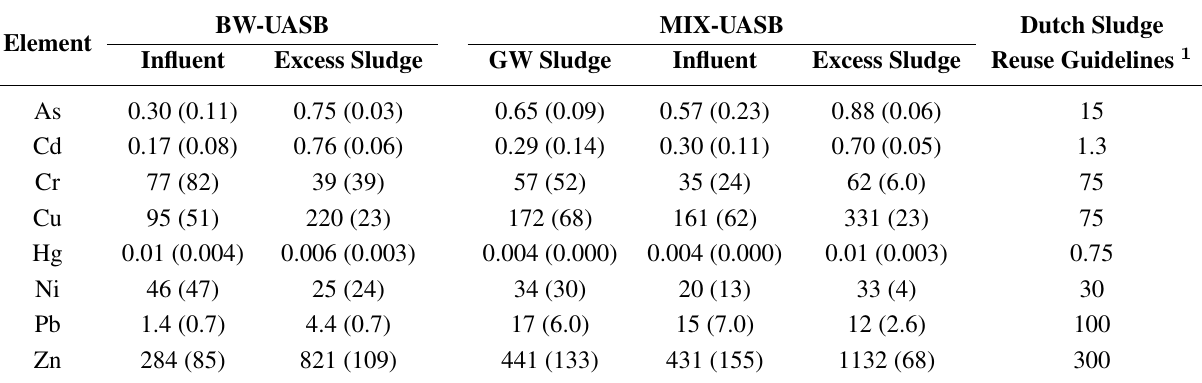
Table 4. Heavy metal content (mg/kgDW) of grey water sludge, influent and excess sludge of the UASB reactors and the Dutch sludge reuse